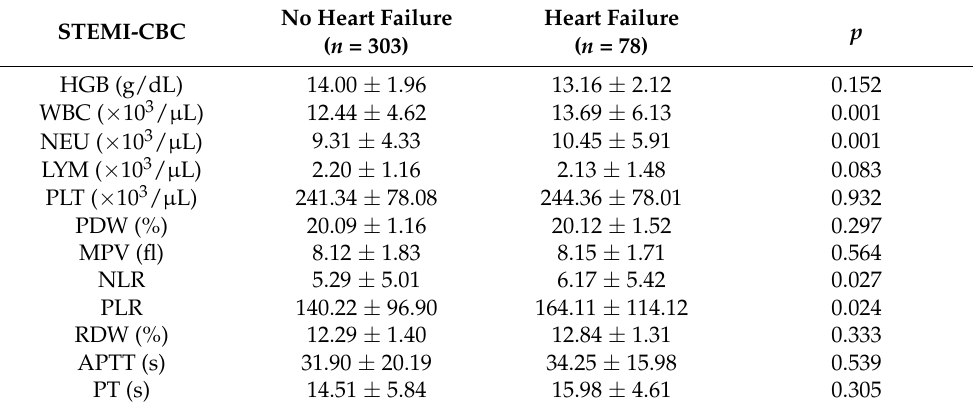
Table 13. Hematological and coagulation parameters of the groups with/without heart failure in STEMI patients.